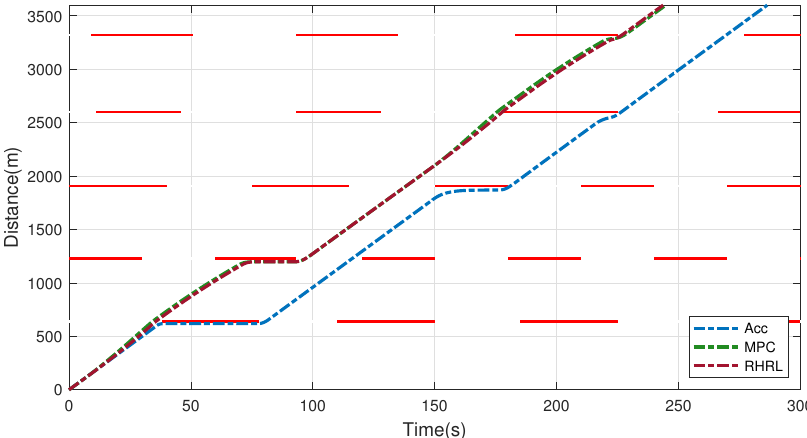
Figure 9. The optimal and nominal trip time–distance results and traffic light schedules.